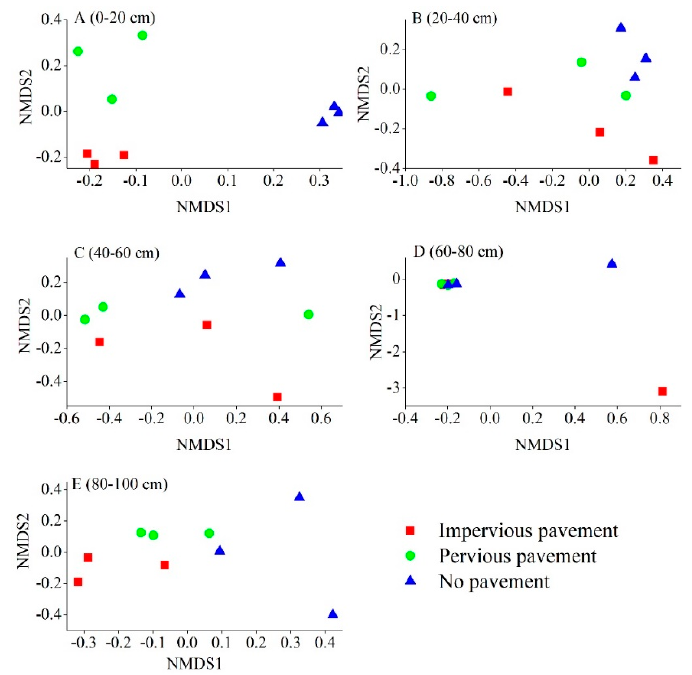
Figure 2. The non-metric multi-dimensional scaling (NMDS) of the bacterial communities comparing all 45 samples from the three pavement types. Sites have been color-coded according to pavement type.